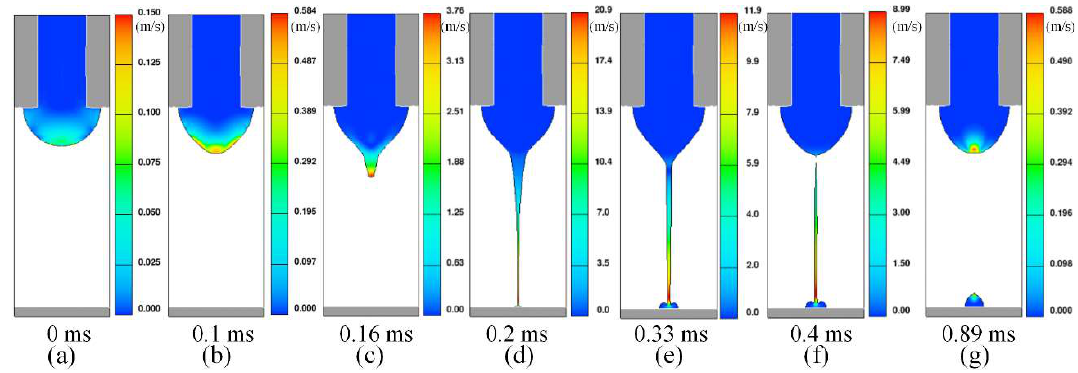
Figure 4. ( a – g ) Velocity distribution at seven representative moments during an injection cycle.